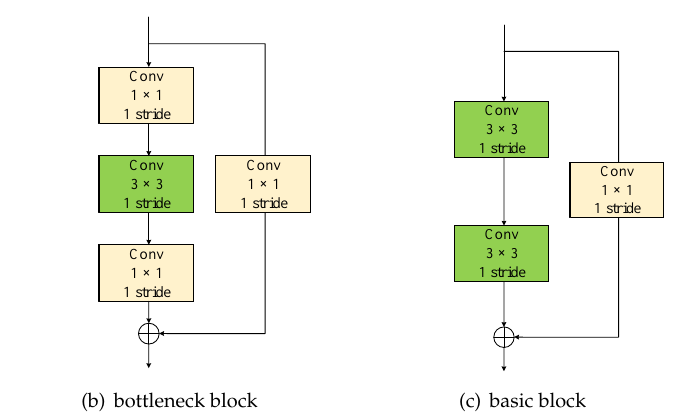
Figure 5. The architecture of our proposed neural network and the module of the bottleneck block and basic block. ( a ) The architecture of our network. ( b ) The architecture of the bottleneck block. ( c ) The architecture of the basic